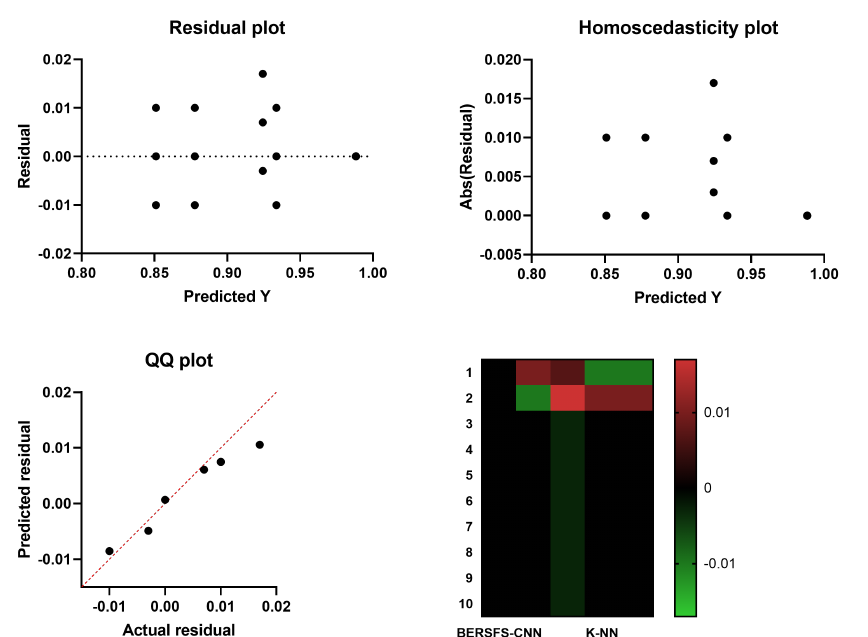
Figure 2. The homoscedasticity graphs, heat maps, residual plots, and QQ plots of the BERSFS and other basic models.